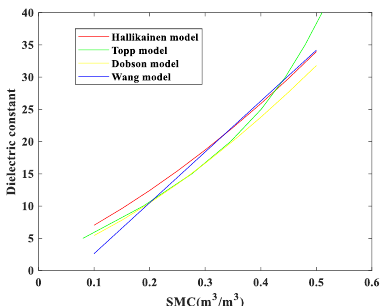
Figure 11 . The four soil models on international loam （ C=0.07 ， S=0.48 ） .